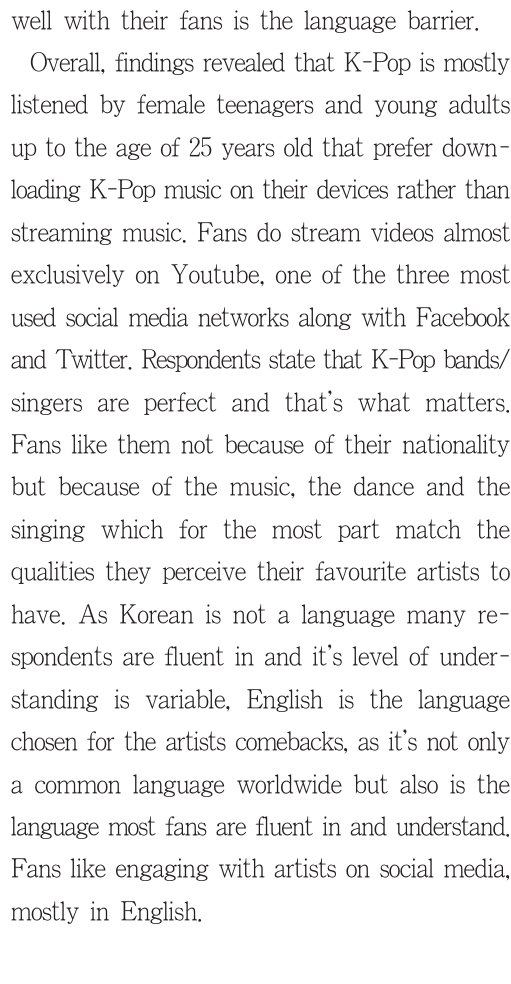
53.2% of respondents are fluent in